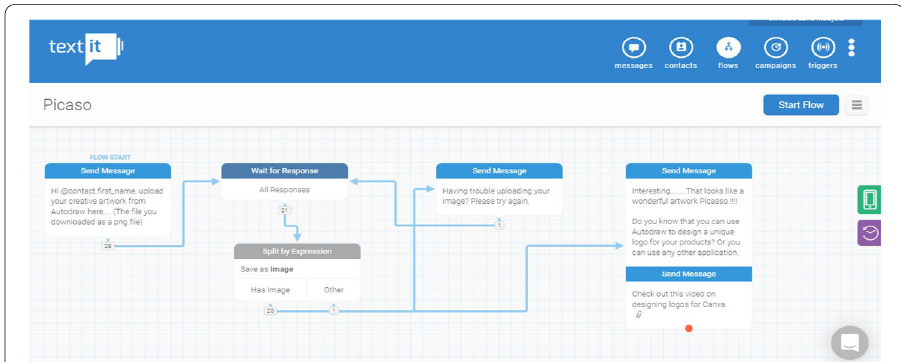
Fig. 1 Textit flow diagrams